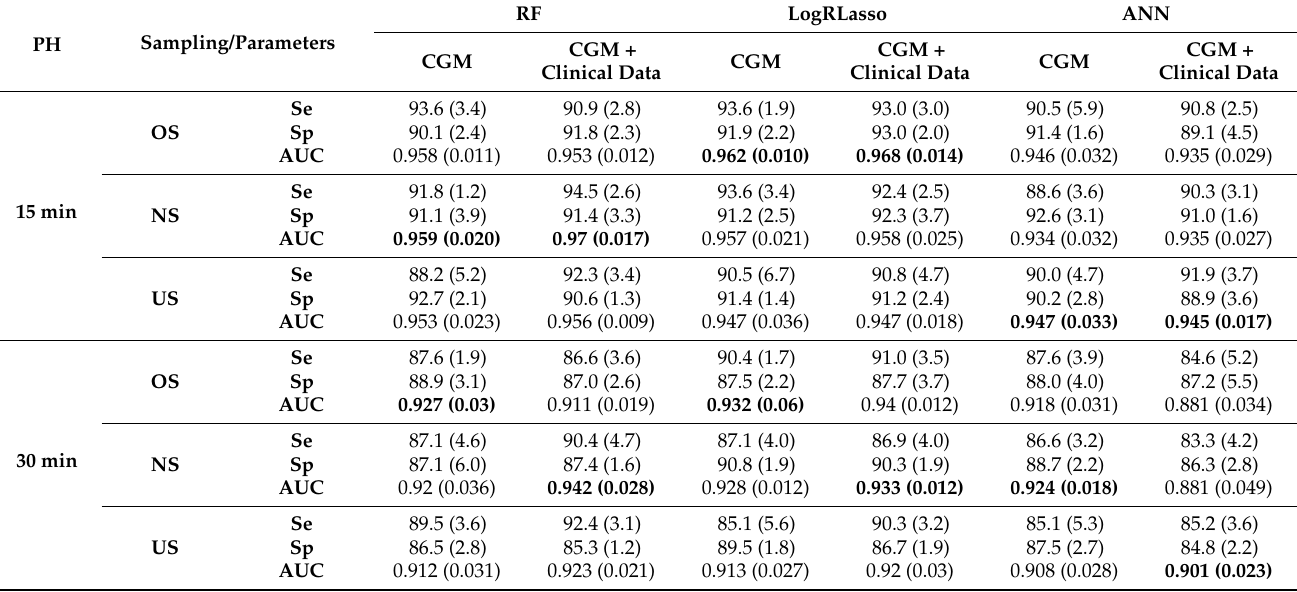
Table 3. Quality metrics (%) of the ML models for NH prediction.